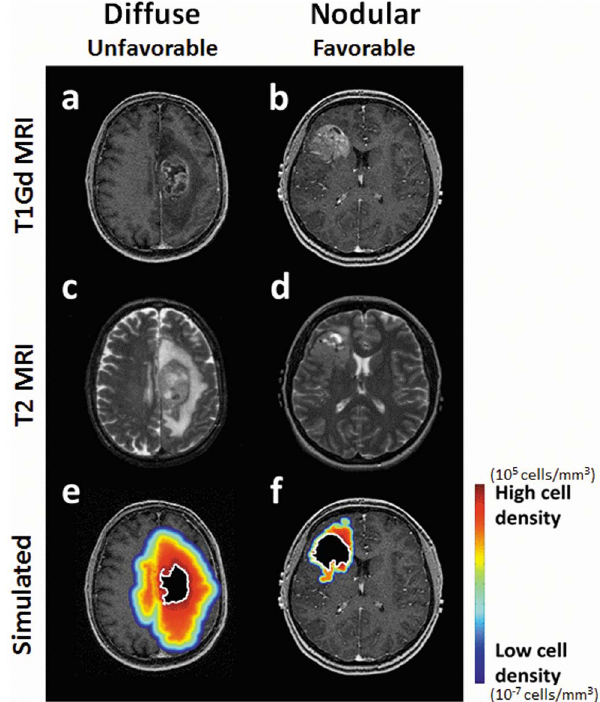
Figure 1. Patient-Specific Simulations of Tumor Cell Distribu- tion and Density for both a Relatively Diffuse and a Relatively Nodular Glioblastoma. T1Gd and T2 MRIs for two newly diagnosed glioblastoma patients, one relatively diffuse with a low r /D (a,c) and one more nodular with a high r /D (b,d). A simulation of the diffuse glioma extent predicted by the patient-specific simulation for the diffuse (low r /D) patient (e) and the more nodular (high r /D) patient (f) is overlayed on the T1Gd MRI with red and blue indicating high and low (but nonzero) glioma cell density, respectively. The effect of GTR is shown as a black region with a white outline and highlights the significant diffuse extent of glioma cells remaining post-GTR. In the more nodular (high r /D) case, GTR removes 75% of the pre-treatment glioma cells leaving 8.4e8 cells while in the diffusely invasive (low r /D) case, GTR removes only 27% of the pre-treatment glioma cells leaving 4.2e9 cells, an order of magnitude higher than the nodular case. The large number of tumor cells remaining after resection of a diffuse tumor drives recurrence.